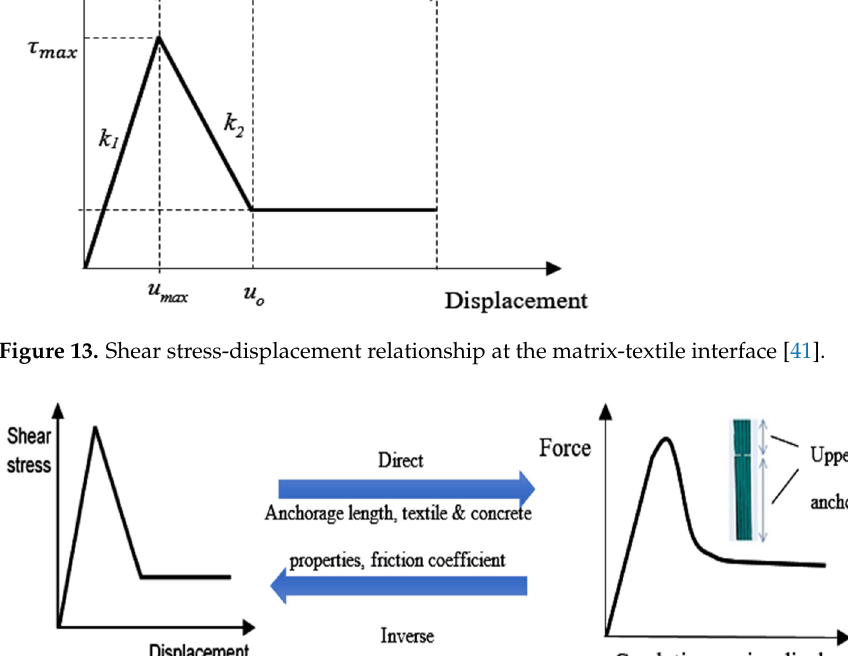
Figure 13. Shear stress–displacement relationship at the matrix–textile interface [41].